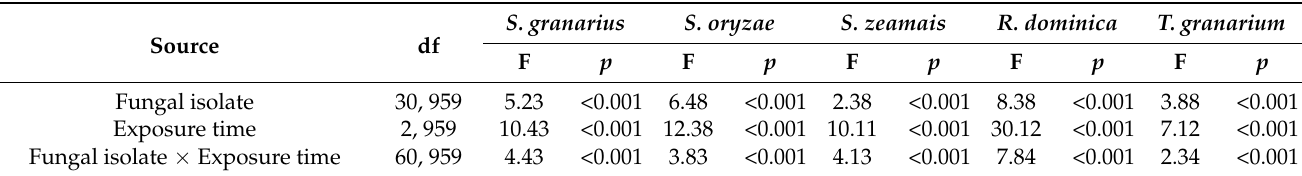
Table 3. Two-way ANOVA results for main effects and interactions for adult mortality of stored product beetle pests exposed to